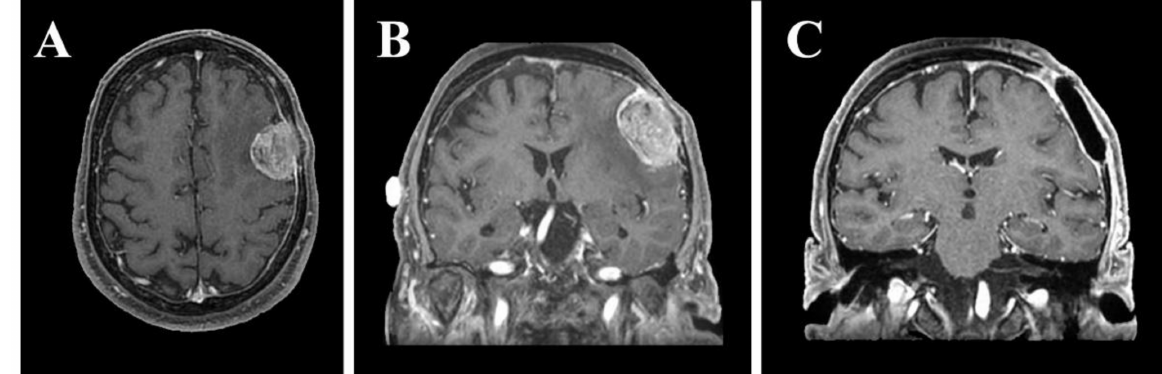
Figure 1. Preoperative axial ( A ) and coronal ( B ) gadolinium-enhanced T1-weighted MRI showing en plaque convexity meningioma. Postoperative coronal gadolinium-enhanced T1-weighted MRI ( C ) showing surgical resection of the tumor and cranioplasty with